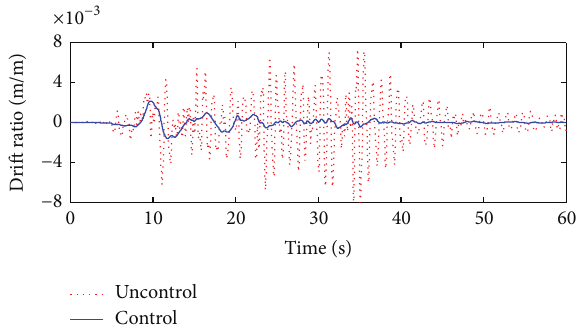
Figure 14: Drift ratio of all five floors for uncontrolled and syn- chronized control coupled with 𝐻 2 / LQG algorithm in El Centro Earthquake (1940).